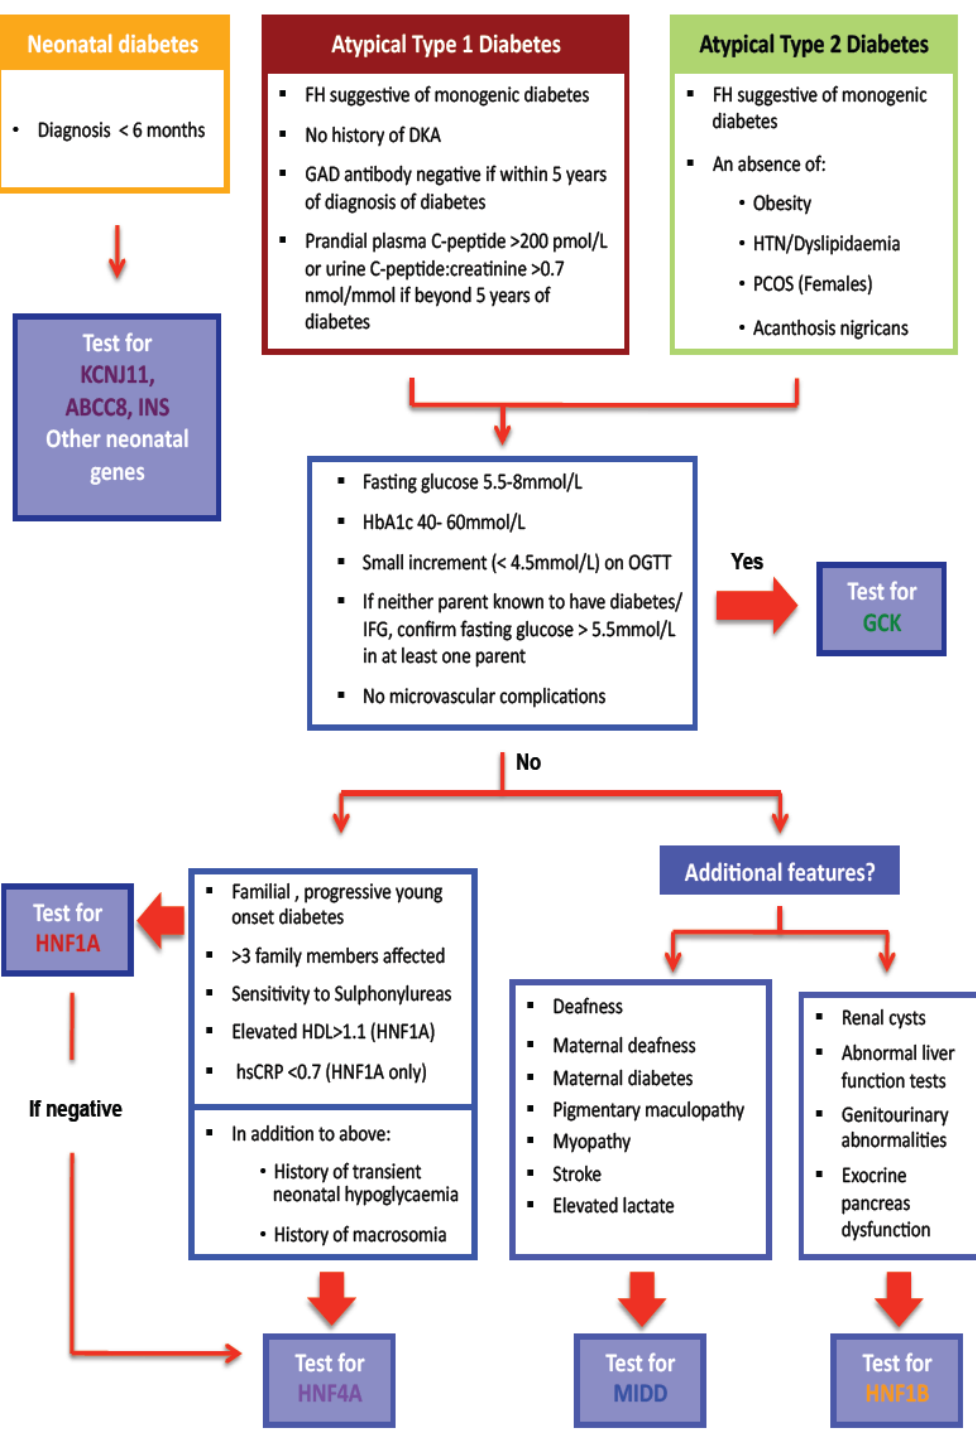
Figure 1. Diagnostic algorithm for assessment of suspected monogenic diabetes: diabetes diagnosed at <35 years of